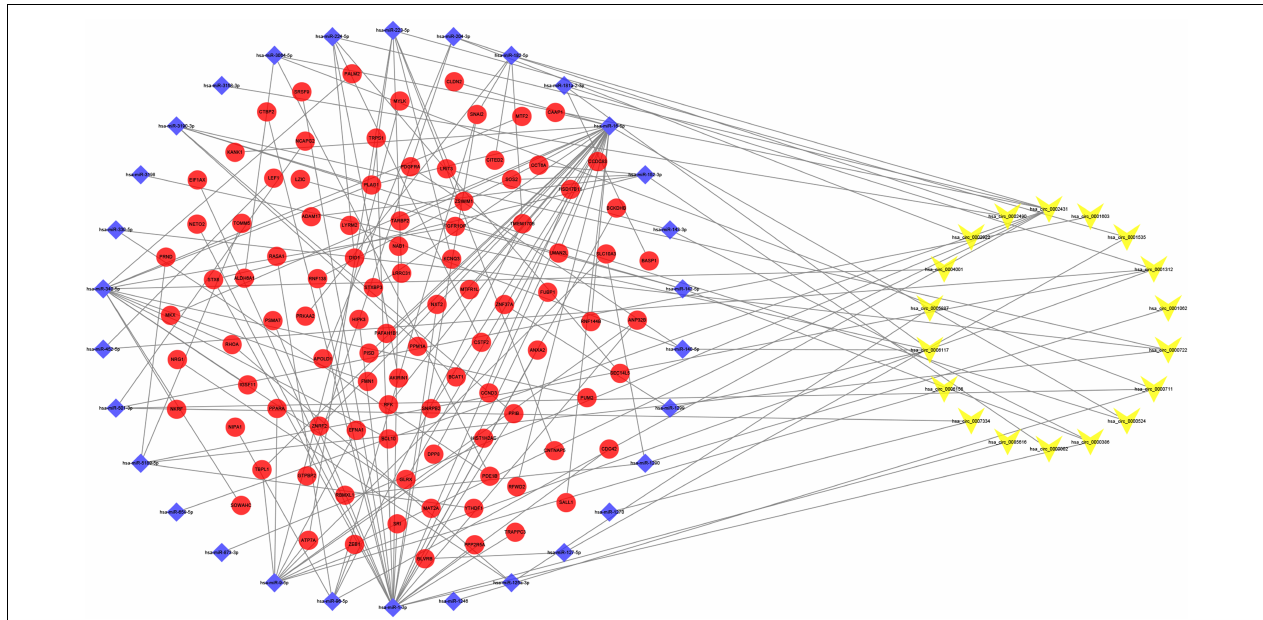
FIGURE 2 | Circular RNA (circRNA)–microRNA (miRNA)–messenger RNA (mRNA) competitive endogenous RNA (ceRNA) network. Yellow-V , blue diamonds , and red ellipses represent circRNAs, miRNAs, and mRNAs, respectively.